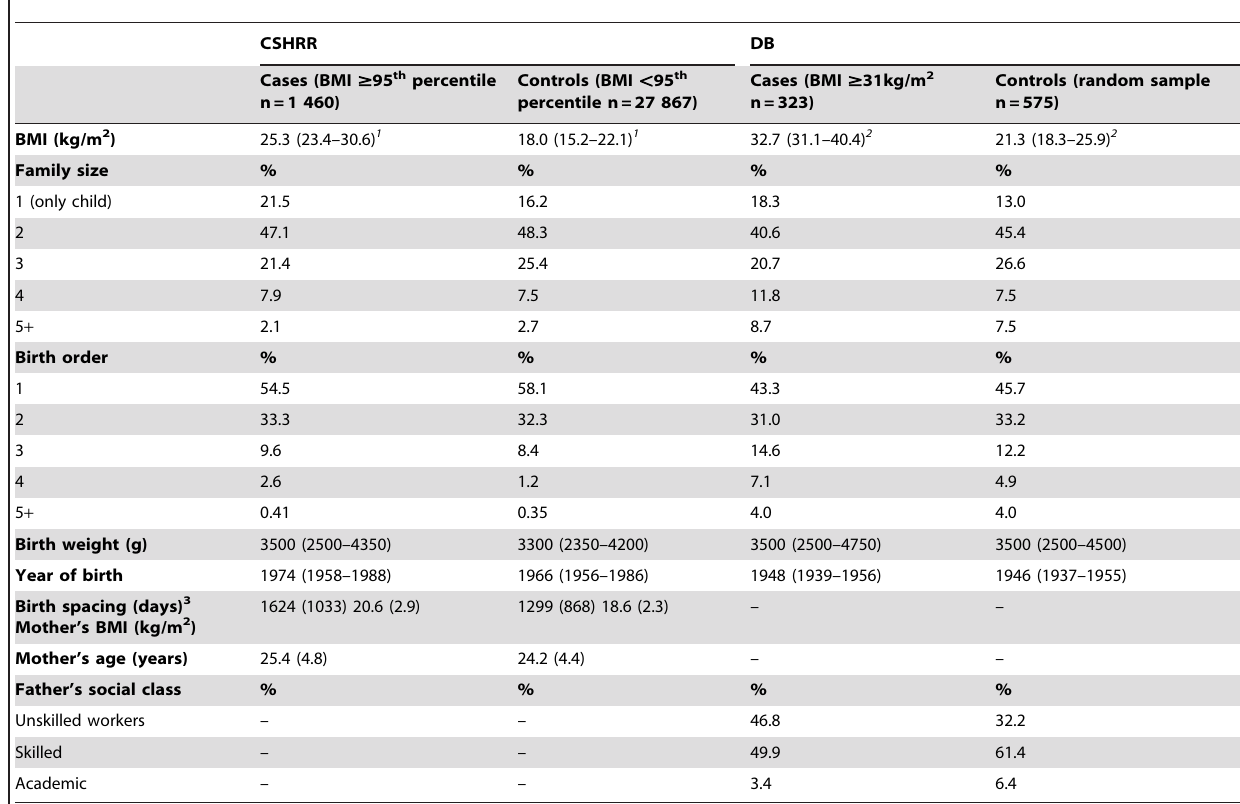
Table 1. Characteristics of the two study populations The Copenhagen School Health Records Register (CSHRR) and The Draft Board (DB) given as median (5–95% interval) and in